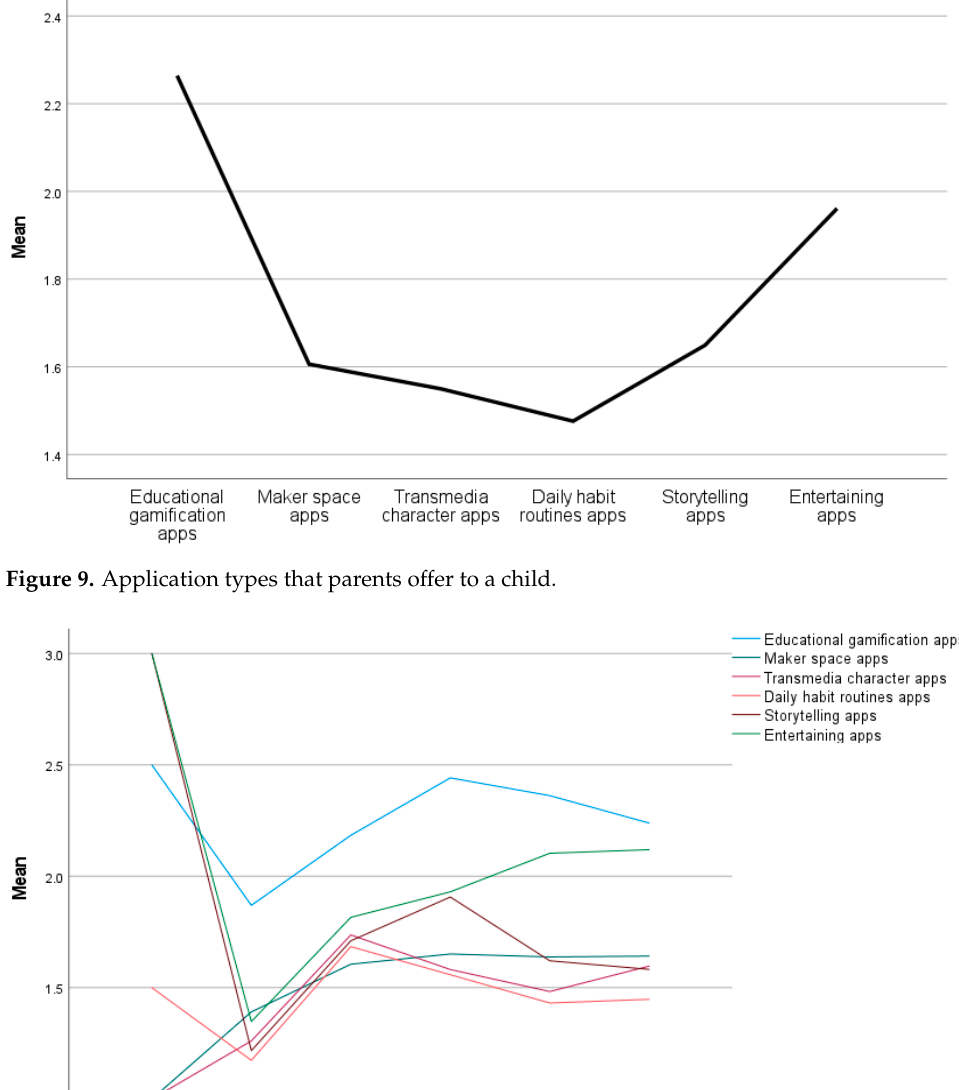
Table 4. Spearman’s correlations of the use of digital screen technology with applications offered by parents; significant correlations are presented.